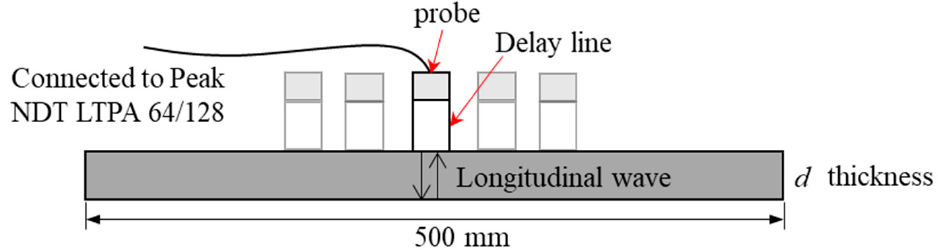
Figure 2. Experimental setup of longitudinal wave testing.